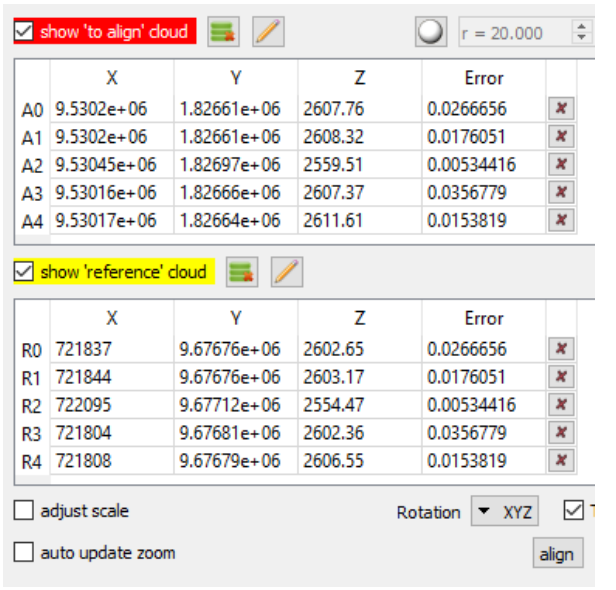
Figure 8. Geo-referencing errors, Lidar – UAV. 3.2 Geo-referencing UAV Feb 02, 18 – UAV Jun 20, 18. The same process was performed, with the point clouds of the temporary images of the UAV, using five points evenly distributed, as illustrated in Figure 9.